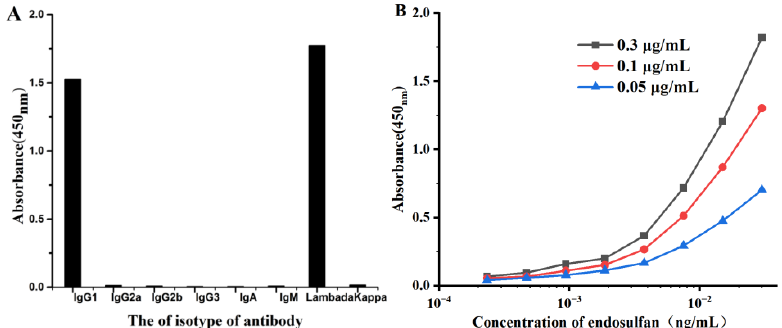
Table 2. Optimization of the pH, methanol content and the NaCl content on endosulfan, through the ic-ELISA assay. Figure 7. Characterization of the hybridoma antibody. ( A ) Isotype determination of mAb. ( B ) Affinity constant result of mAb.